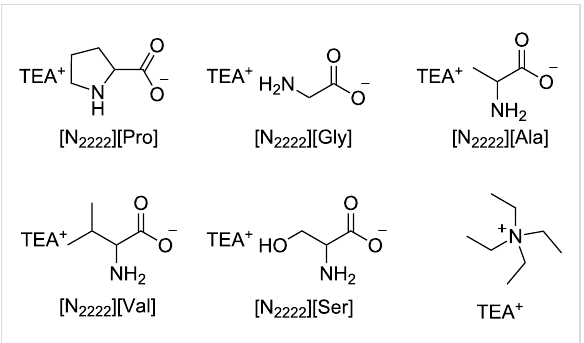
Figure 3: Representative examples of ionic liquids for biodiesel pro- duction.